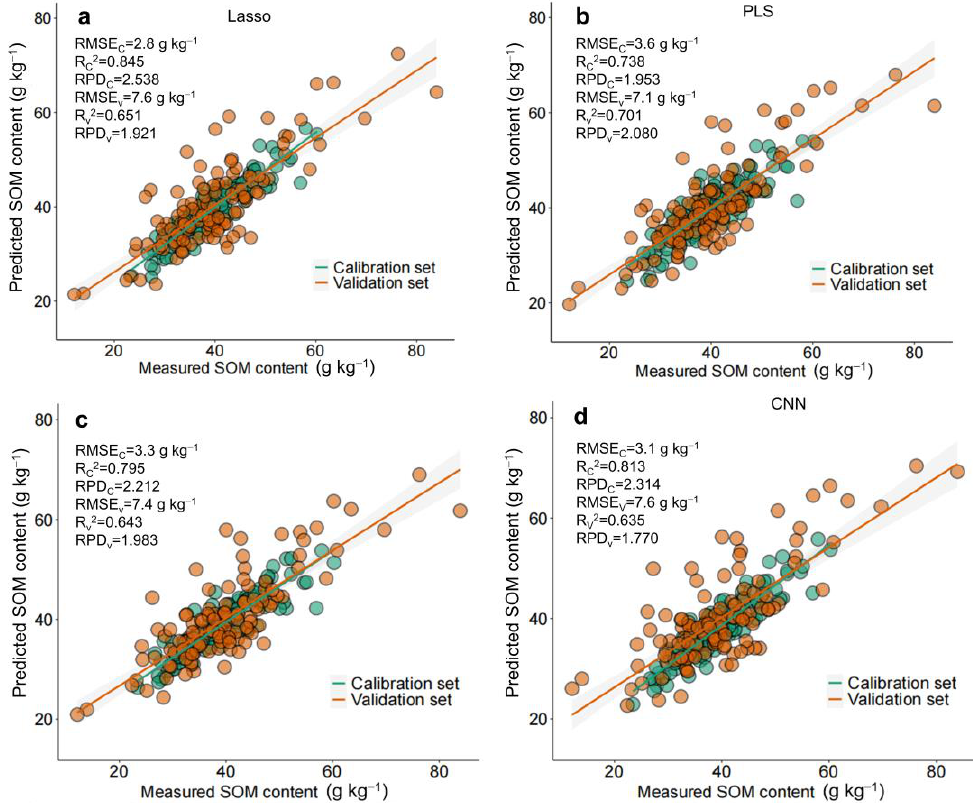
Figure 5. Scatter plots of measured and predicted SOM contents by Lasso ( a ), partial least square (PLS, ( b )), support vector regression (SVR, ( c )), and convolutional neural network (CNN, ( d )) models based on FTIR-ATR spectra. based on FTIR-ATR